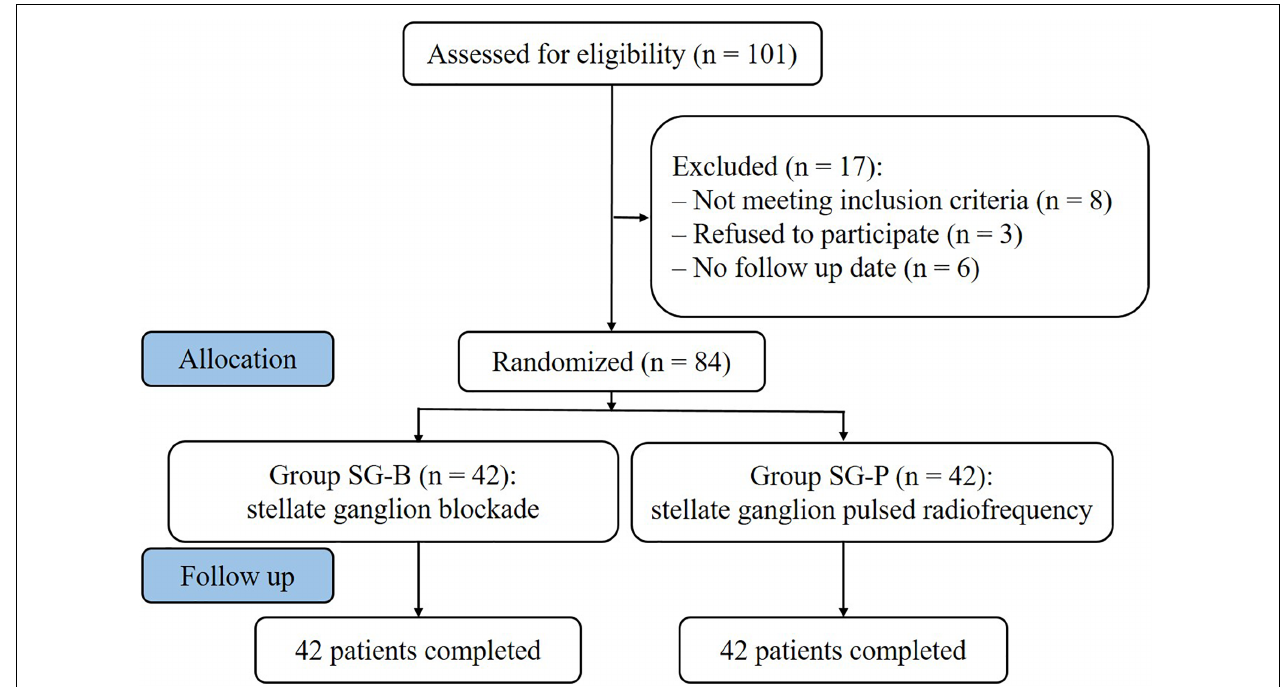
FIGURE 1 | Study flowchart. All 84 patients were included in the